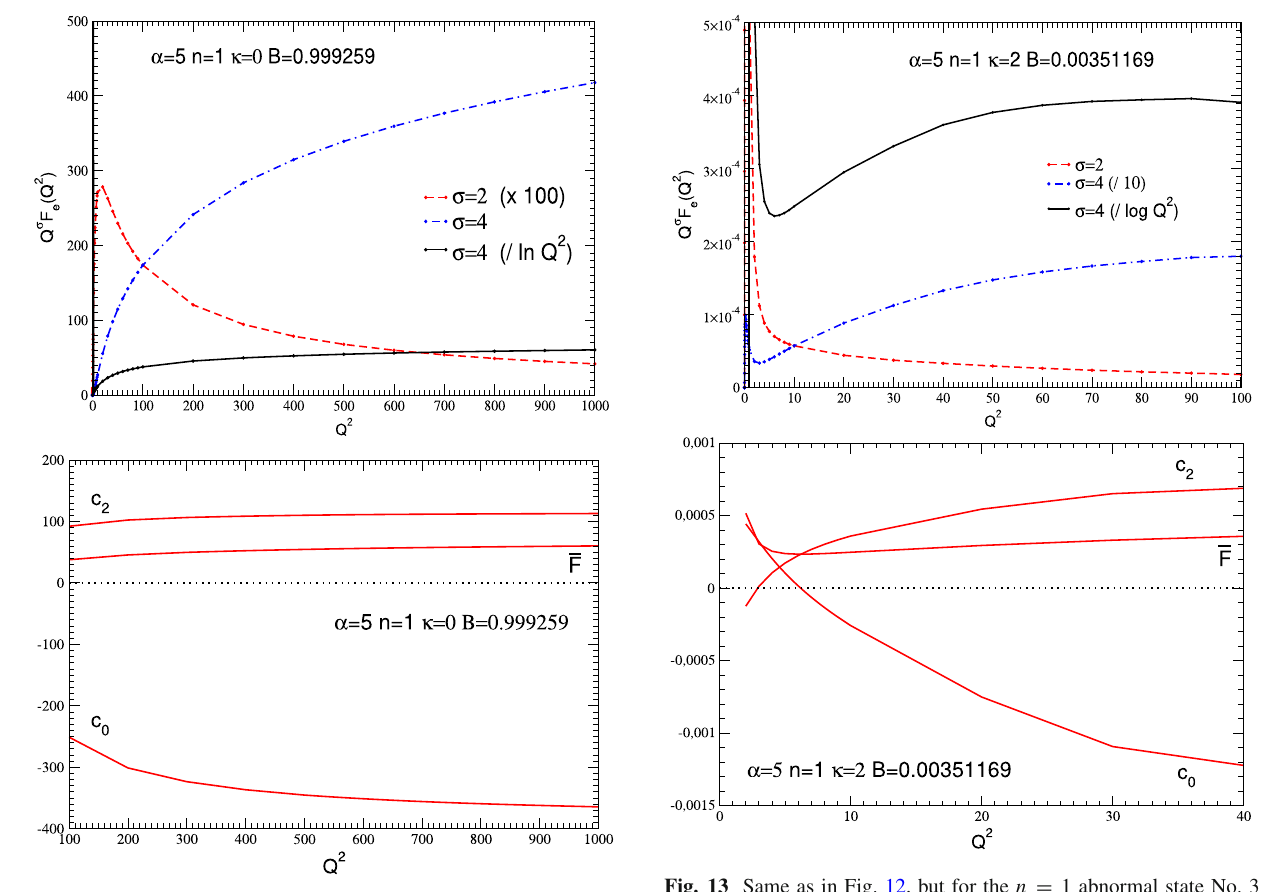
Fig. 12 Asymptotic behaviours of the elastic form factor of the n = 1 state No. 1 of Table 1. Upper panel: the elastic form factor F e multiplied by Q σ with σ = 2 (red), σ = 4 (blue), and σ = 4 divided by ln ( Q 2 ) . Lower panel: the asymptotic coefficients c 0 and c 2 defined in Eq. (39)